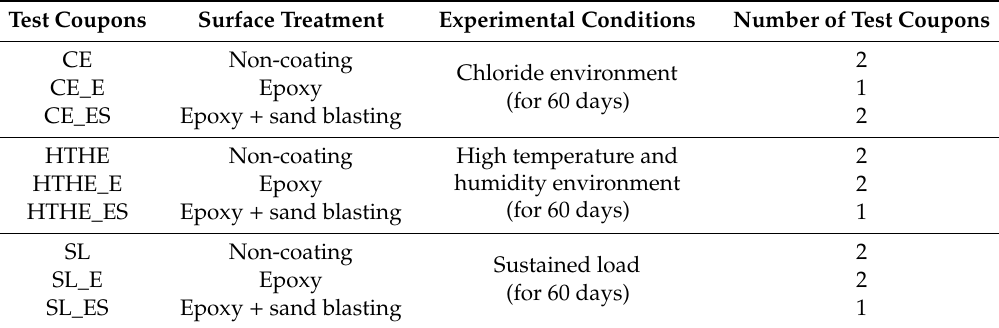
Table 1. Properties of the textile-reinforced mortar (TRM) coupons.